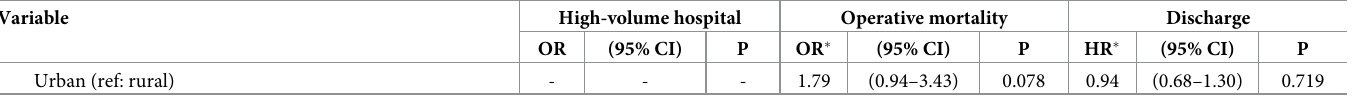
hospital location, size, and